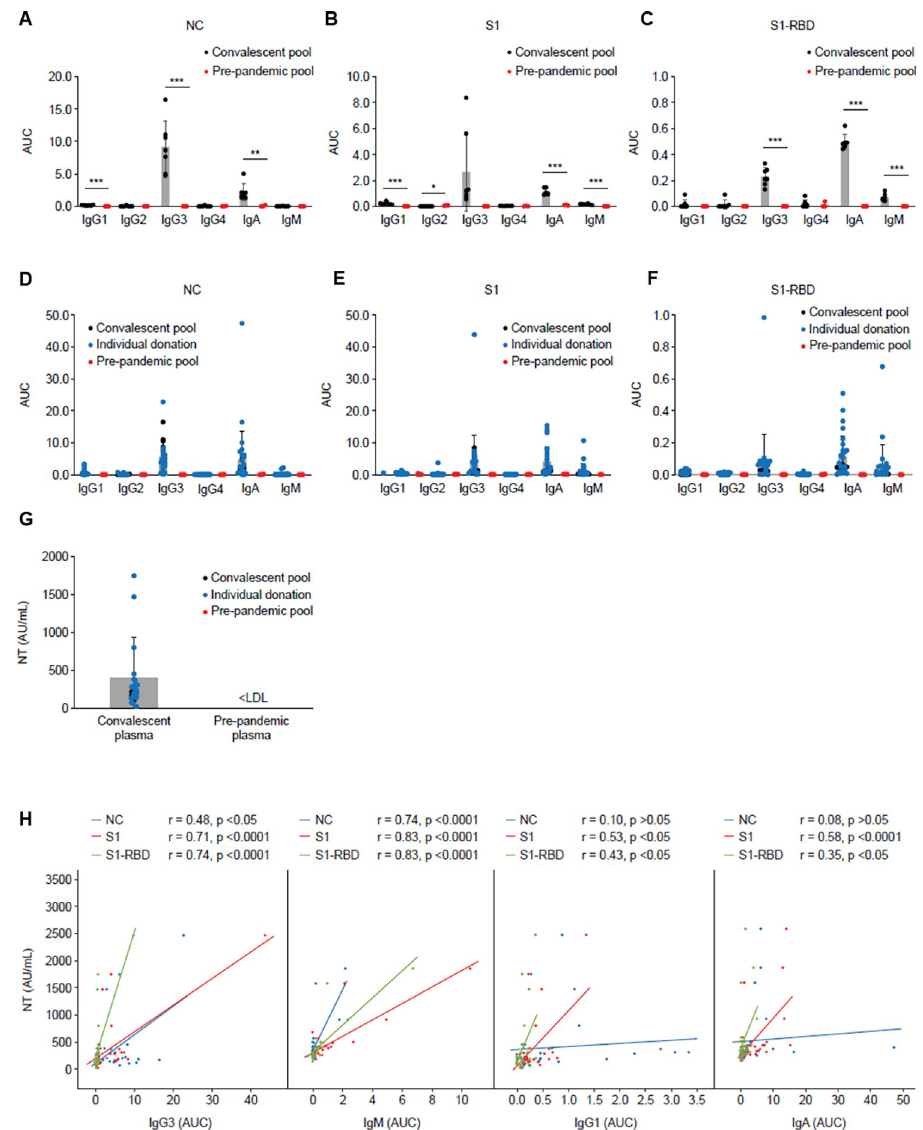
Fig 3. Binding capability of SARS-CoV-2 specific antibody Ig classes utilizing ELISAs to different viral antigens in selected individual convalescent donors and pools to SARS-CoV-2 viral antigens and correlation analysis. (A–C) Ig classes of seven convalescent and three pre-pandemic plasma pools against: A) NC; B) S1; C) S1-RBD. Data are shown as mean ± SD. Asterisks indicate the level of statistical significance calculated using the Student’s t-test: � p � 0.05, �� p � 0.01, and ��� p � 0.001. AUC, area under the curve. (D-F) Overlay of specific binding capacity of individual donors, plasma pools, and pre-pandemic plasma pools against D) NC, E) S1, and F) S1-RBD respectively. (G) Neutralizing potency (AU/ml) of pre-pandemic pools, convalescent pools, and individual donors. AU, arbitrary unit; < LDL, below lower detection limit. (H) Pearson’s r values are shown as an indicator of correlation between the neutralization potency and IgG3, IgM, IgG1, and IgA with specificity for the NC (blue), S1 (red), or RBD (green) viral antigens. Seven convalescent plasma pools as well as selected individual donors with high, medium, or low NT titers were used for calculation. NC, nucleocapsid; S1, viral antigen S1; S1-RBD, receptor-binding domain of S1; SD, standard